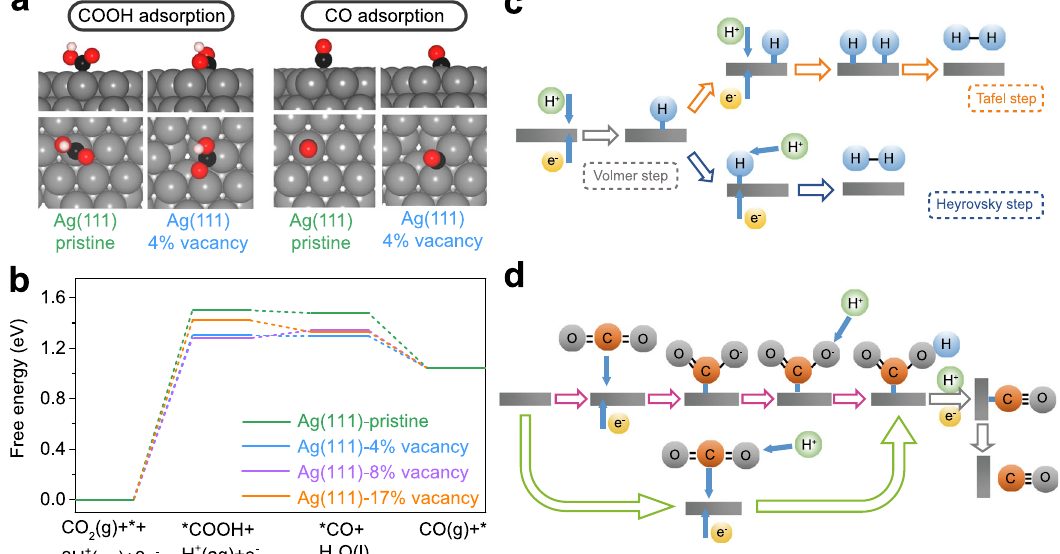
Fig. 5 Theoretical study for assessing improved ECR performance. a The most preferred binding geometries of adsorbate on pristine Ag (111) and 4% vacancy-defected Ag (111). Side view: above; top view: below. Colour codes: Ag, grey; C, black; O, red; H, pink. b Calculated free energy diagrams. Proposed reaction pathways for c HER in acidic solutions and d ECR to CO on the surface of electrodes.